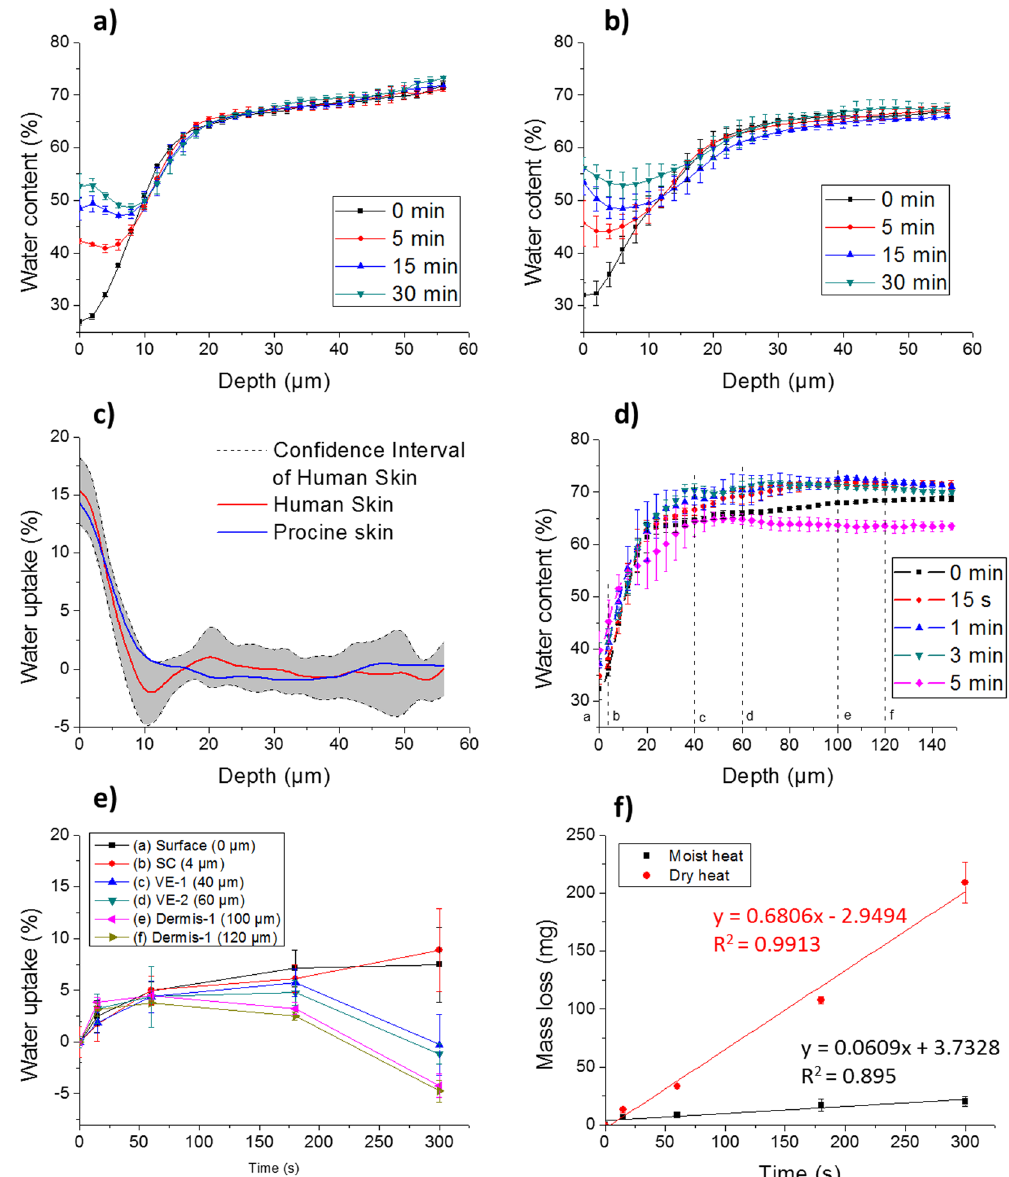
Figure 1. Differences in the skin hydration depth profiles before and after 5, 15 and 30 min water exposure. ( a ) Human skin ( in vivo ) ( b ) Porcine ear skin ( ex vivo ) ( c ) Water uptake profiles of human skin marked with confidence interval and porcine skin after 5 min exposure. ( d ) Depth profiles of water content change after different steam exposure, ( e ) water uptake at different depths as a function of steam exposure times [( a ) 0 µ m